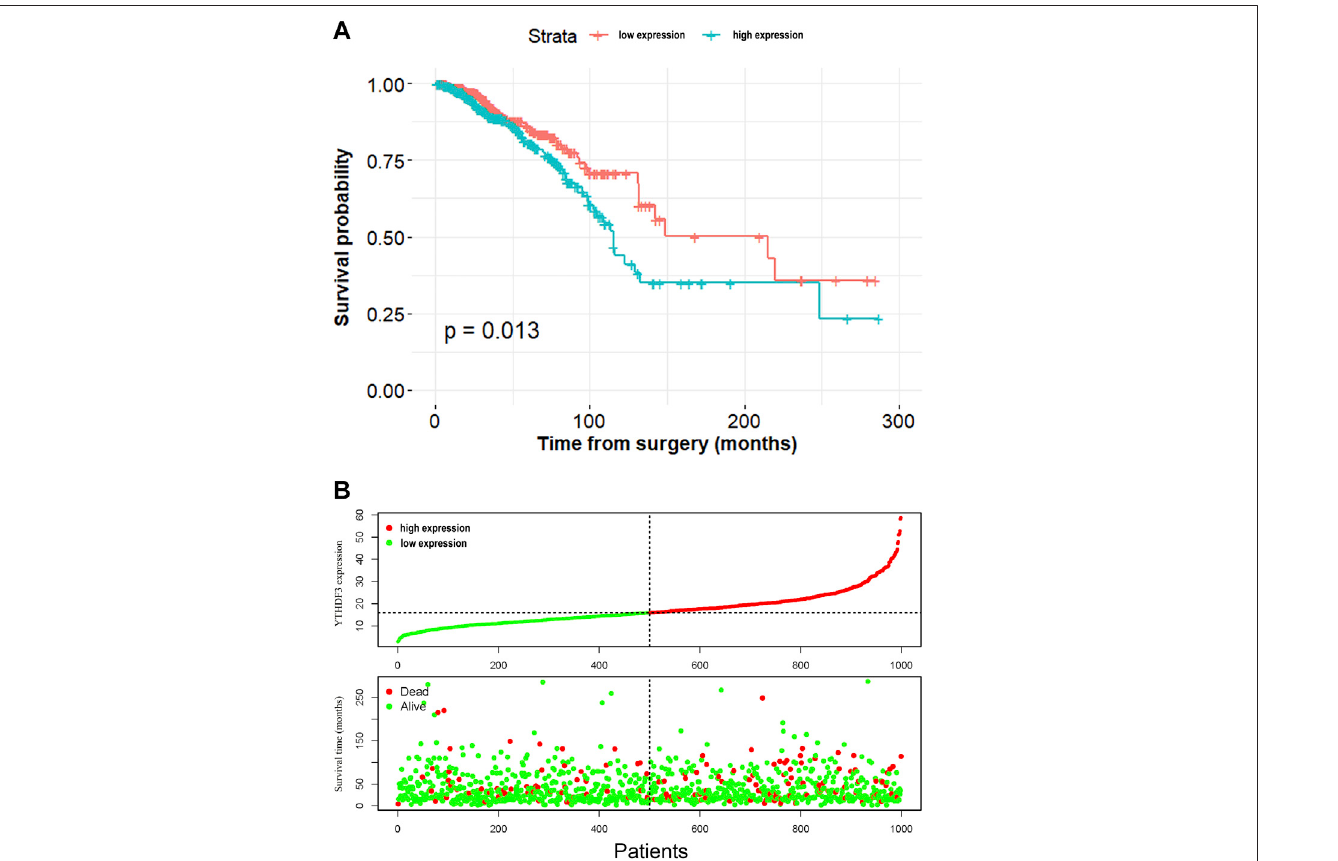
FIGURE2|(A) K-M curvesofpatients inhigh- and low-expressiongroups based on themedian value ofYTHDF3expression. (B) YTHDF3expression distribution and survival status.